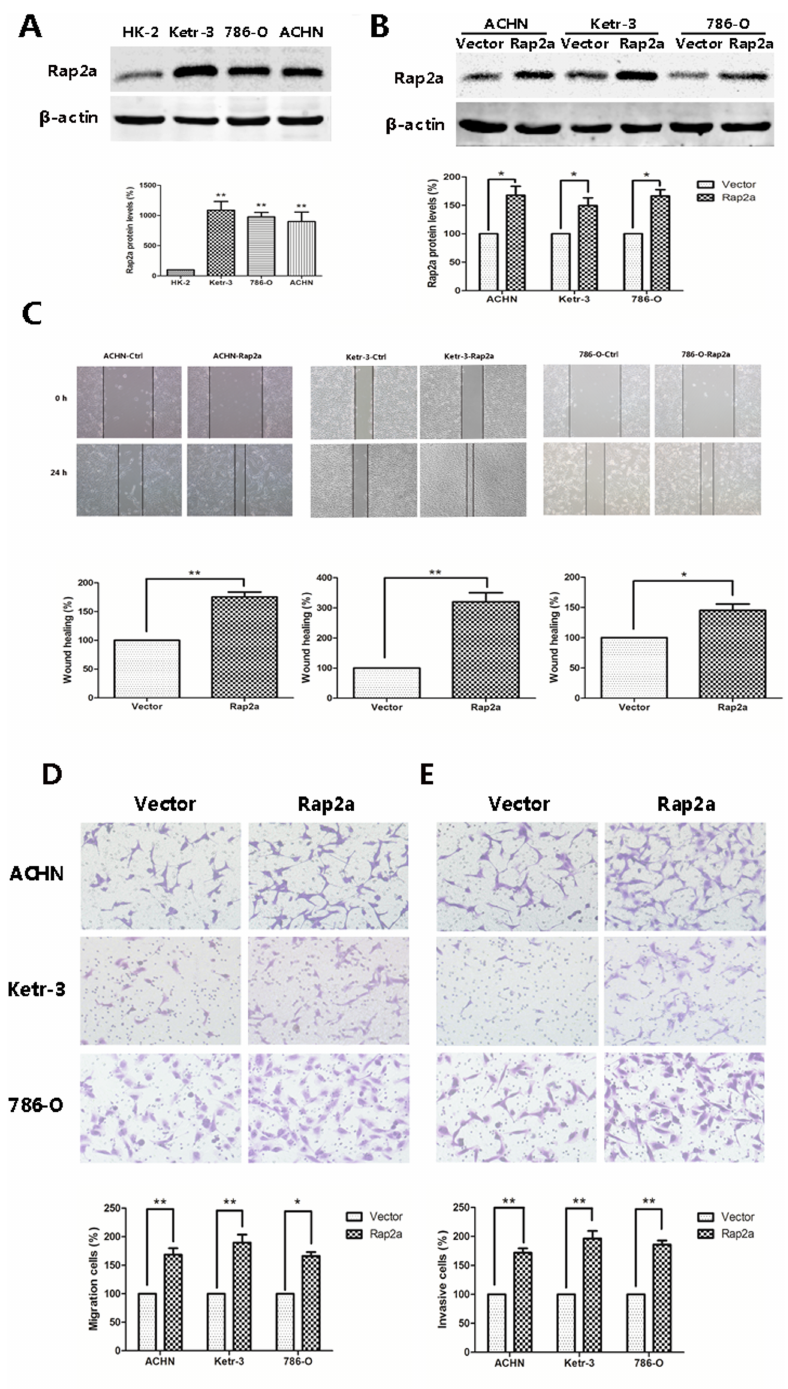
Figure 2. A ) Western blot analysis of Rap2a expression in HK-2, Ketr-3, 786-O and ACHN. β B ) ACHN, Ketr-3 and 786-O cell lines were transfected with Rap2a expressing or empty vector. Twenty-four hours post-transfection, Rap2a protein expression was detected by western blot. ( C in ACHN, Ketr-3 and 786-O cells. ( D , E ) Cell migration was measured by using a migration assay following the transfection of RCC cells with Rap2a expression plasmid. Invasion assays were performed by using a similar ± SD (n = 3). * P < 0.05, ** P <